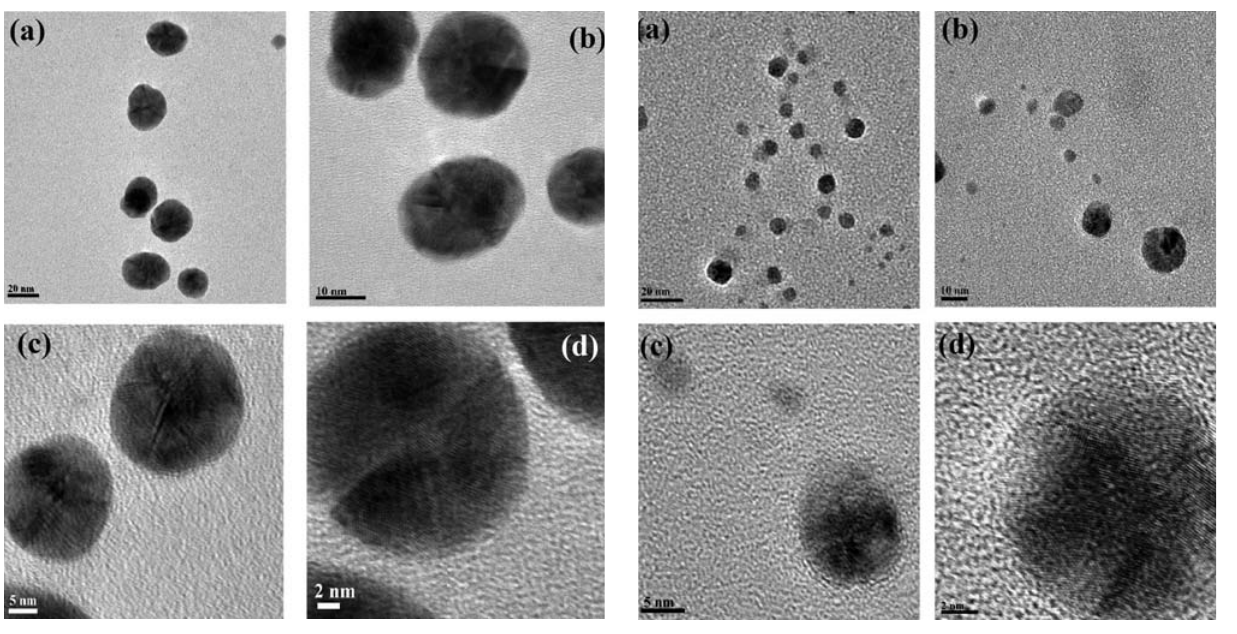
Figure 4. TEM micrograph of the g1.